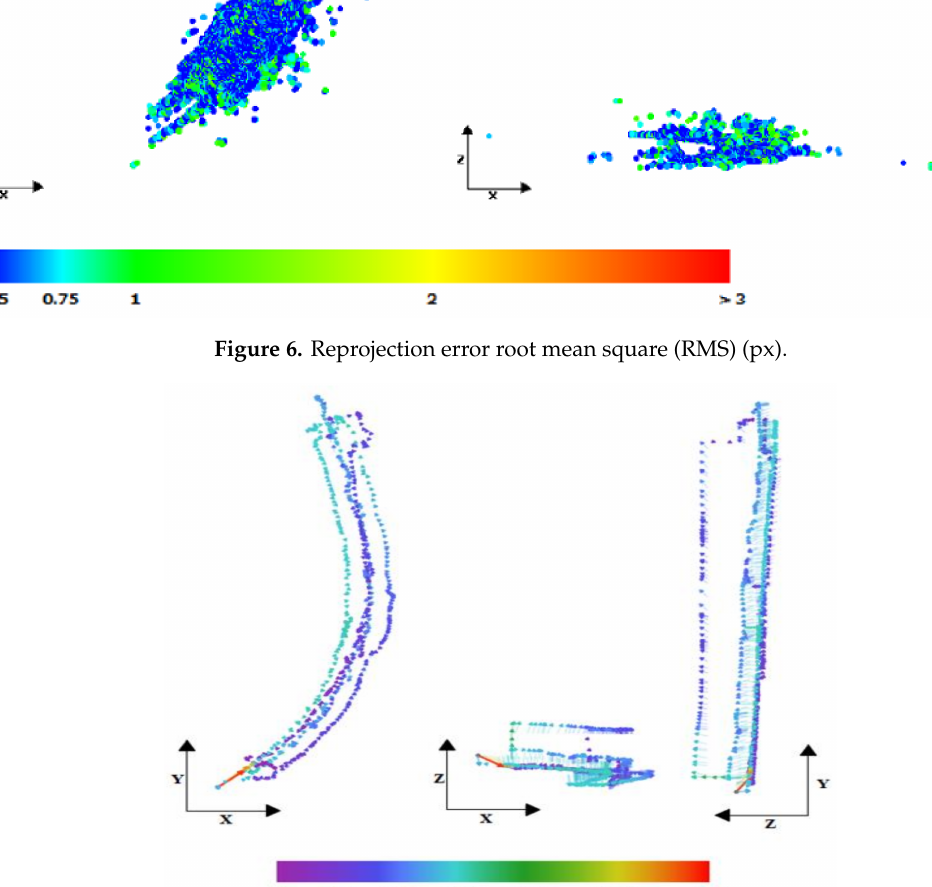
Figure 7. Distance between computed image and metadata